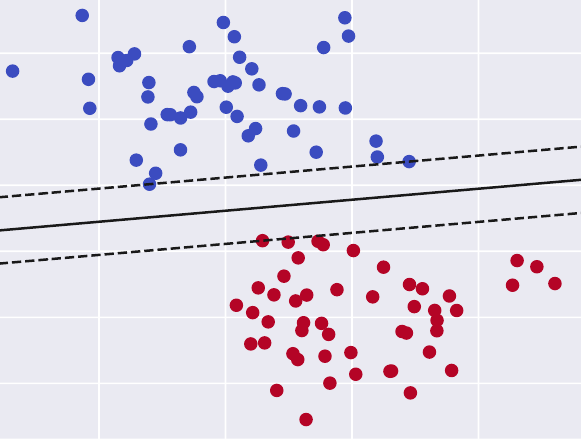
Figure 4. Binary classification problem using the support vector machine